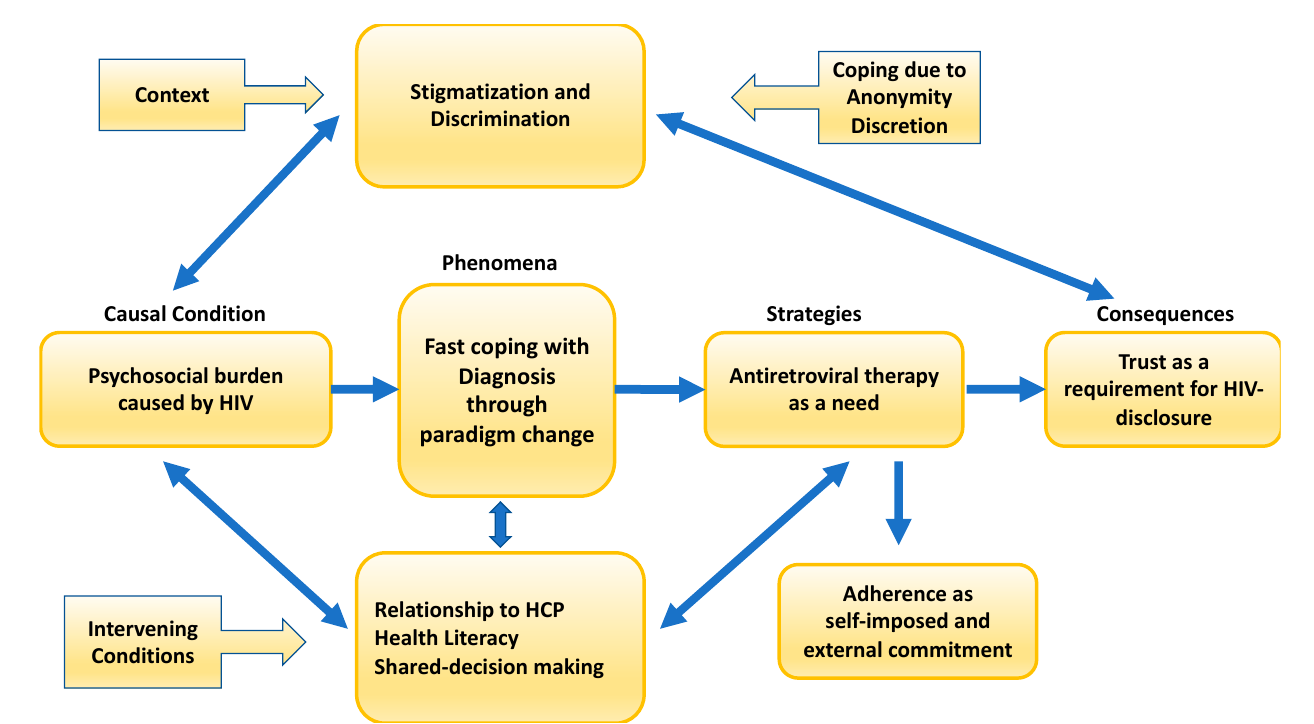
Figure 2. Coding paradigm (own presentation).